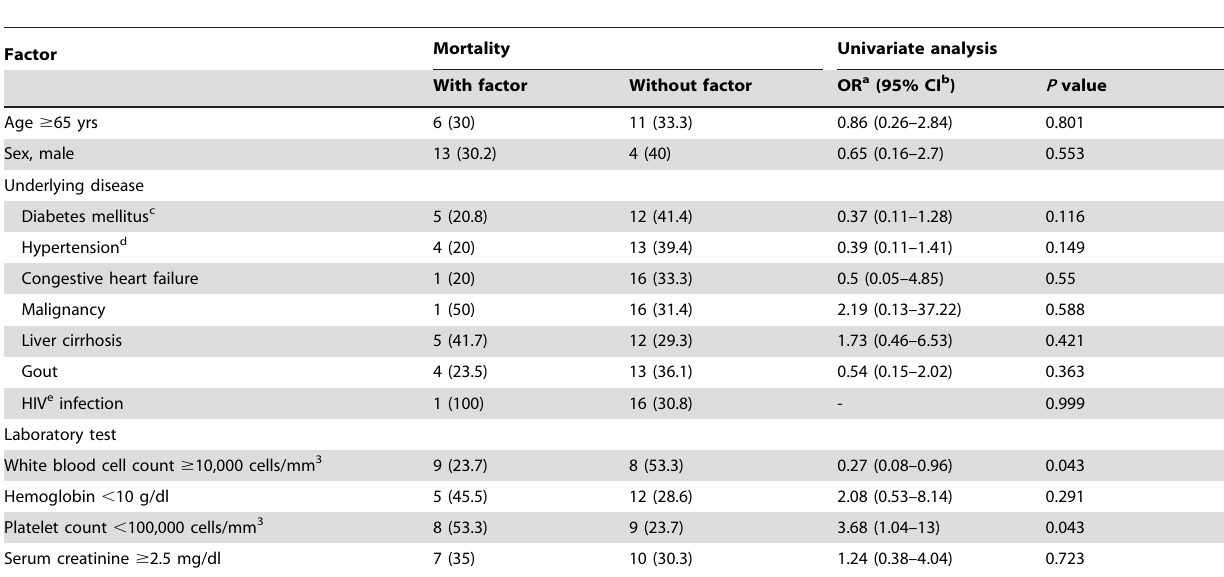
Table 3. Clinical Factors for Mortality in Patients with Streptococcal Toxic Shock